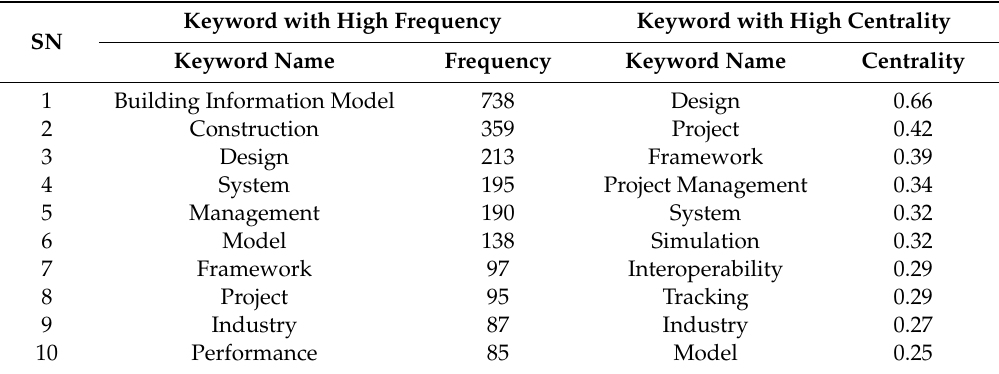
Table 7. High-Frequency keyword of BIM research during 2004–2019.